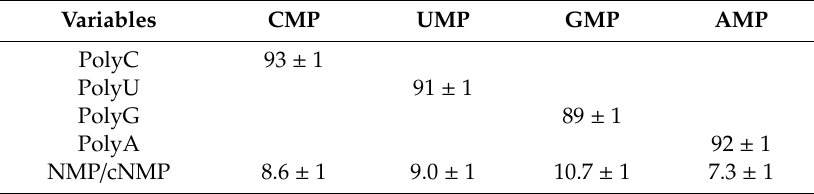
Table 3. Results of the digestion by S1 Nuclease of each polyNMP: recovery percentage as ratio of the recovered amount from HPLC vs. the loaded one and ratio between NMP and cNMP (cyclic NMP) areas.